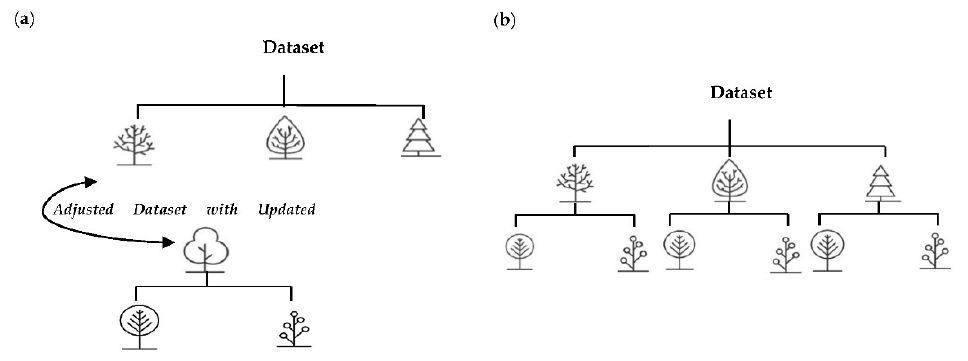
Figure 7. ( a ) Decision stumps in Adaboost based on the boosting method; ( b ) decision trees in RF with the bagging